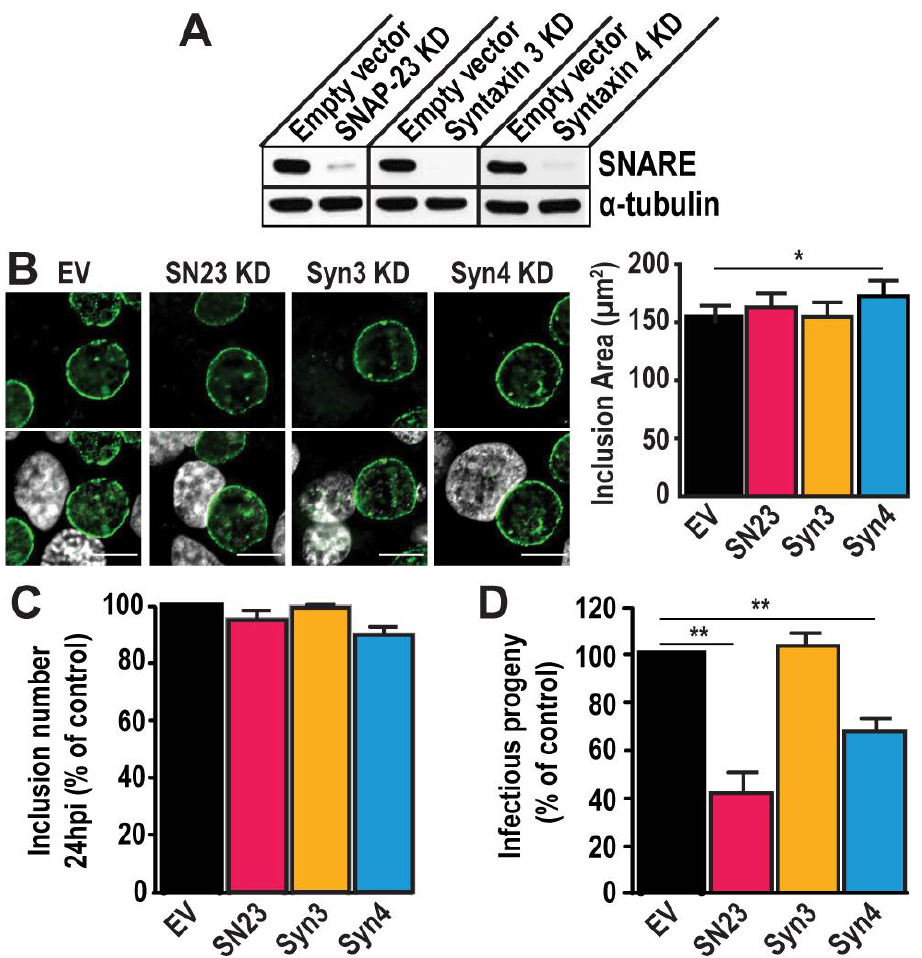
FIGURE 2: SNAP-23 and Syntaxin 4 regulate Chlamydia development. (A) Western blot analysis of protein levels in the indicated CRISPR knock down (KD) cell populations. SNARE corresponds to the t-SNARE in the KD cell line. Alpha-tubulin served as a loading control. (B) Left - The KD cell lines were infected with C. trachomatis L2 at a MOI of 0.5 for 24 h, then fixed and stained with anti-IncA antibody